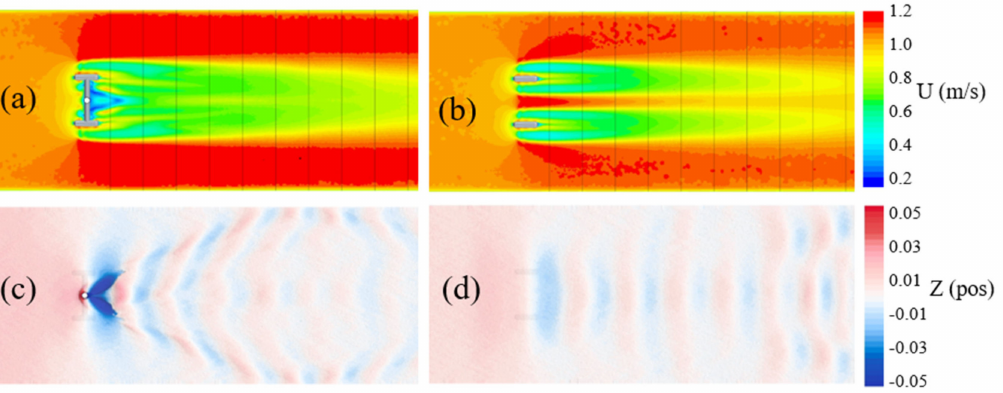
Figure 11. ( a , b ) Velocity and ( c , d ) surface water measurements graphics for the RM1 full model vs. the RM1 rotor and nacelle only.